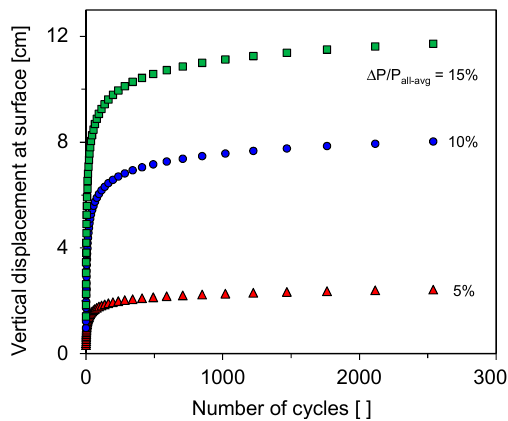
Figure 6. The effect of cyclic internal stress amplitude on the displacement evolution of an unlined energy storage. Cyclic internal stress amplitudes Δ P are defined by 5%, 10%, and 15% of average internal stress P avg . The case storage location z o = 30 m and the storage width w = 21 m.